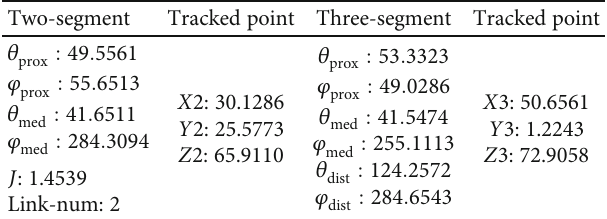
Table 7: Optimized results for a three-segment catheter with variable length without interaction with fragile structures like